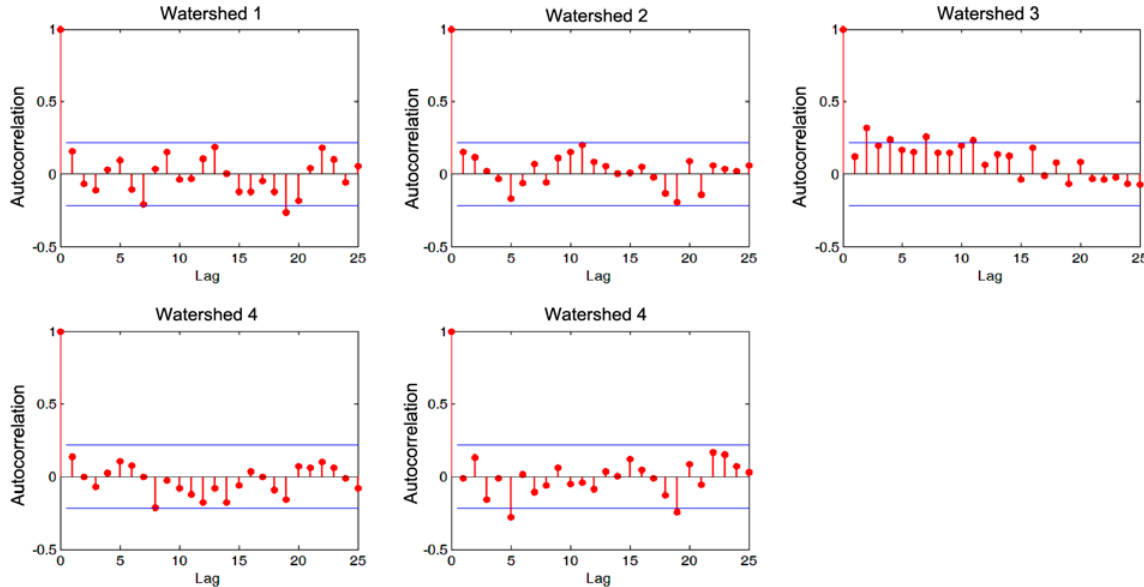
Fig. 5. Autocorrelation function for different lags of monthly runoff of watersheds